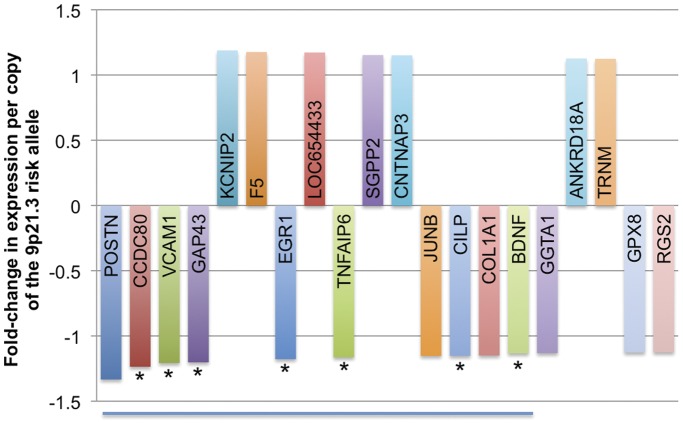
Twenty top-ranked genes altered in association with the 9p21.3 risk allele in donor hearts (n = 108).Analysis was performed using a fold-change threshold of >1.1 per copy of the risk allele and p<0.05 (adjusted for age, gender, ethnicity and cause of death; not corrected for multiple comparisons). Each bar represents an individual gene, as indicated by the gene symbol. Genes are ranked in order of fold-change from greatest to smallest (left to right). Analysis of the top 10 most down-regulated genes (indicated by line below graph) identified a shared combination transcription factor binding sites within the promoter regions of 7 of these genes (genes indicated by asterisks).